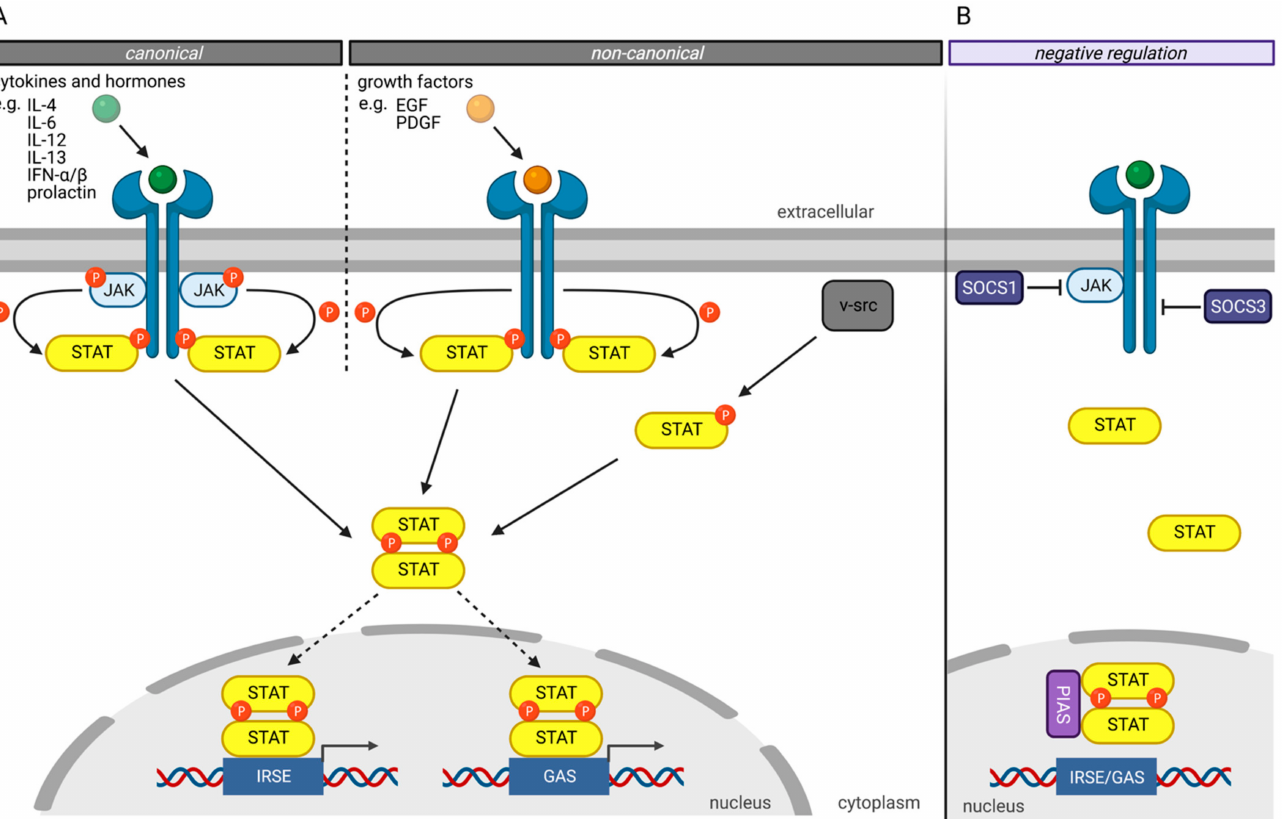
Figure 2. Schematic illustration of different ways of STAT activation and negative regulation. ( A ) STATs are activated by phosphorylation. In the canonical JAK/STAT pathway, extracellular binding of cytokines or hormones to cytokine receptors activates receptor-associated JAKs, which then phosphorylate STATs. Non-canonical signaling includes growth hormone receptors, like the EGF-receptor, which can phosphorylate STATs directly. Furthermore, viral oncoproteins, like v-src, activate STAT constitutively. Phosphorylated STATs form homo- or heterodimers and translocate to the nucleus. They regulate gene expression by binding to IRSE or GAS in the promoter region of their target genes. ( B ) Negative regulation of JAK/STAT pathway includes inhibition of JAK proteins by SOCS1, whereas SOCS3 binds to JAK-proximal sites on transmembrane receptors and inhibits binding of STATs to receptors. PIAS binds to STAT dimers in the nucleus, thereby inhibiting their transcriptional activity. (Created with BioRender.com, accessed on 10 September